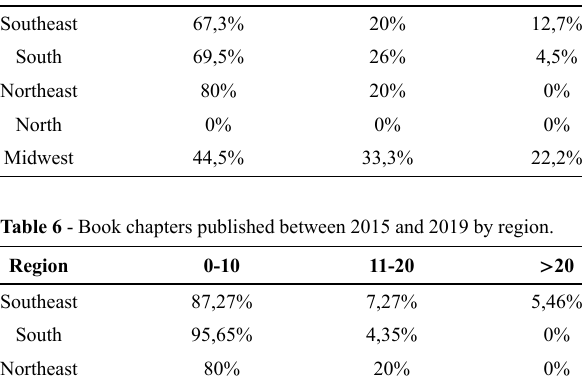
Table 5 - Articles published between 2015 and 2019 by region. Region > 100